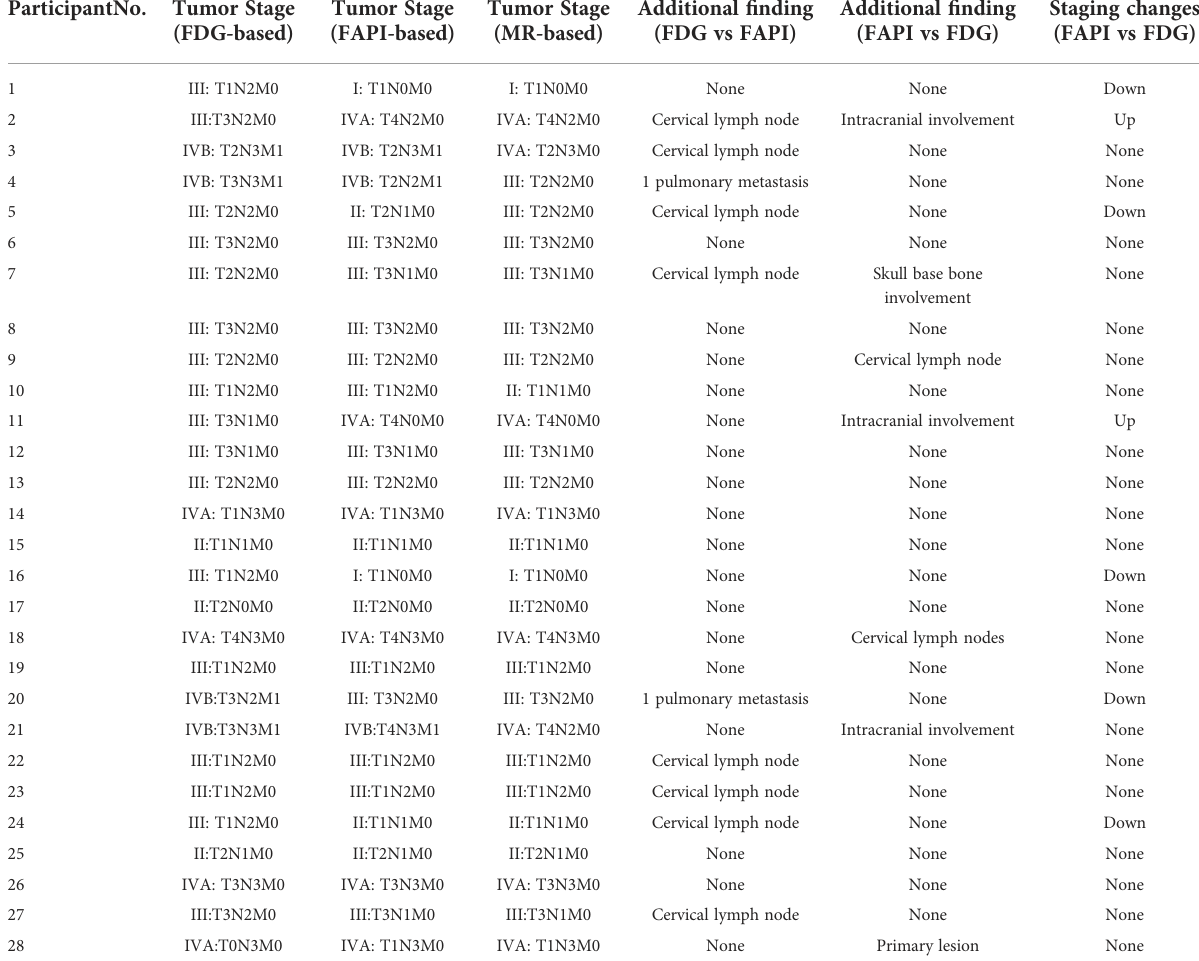
TABLE 4 Comparison of MR, 18 F-FDG, and 68 Ga-FAPI-04 PET/CT-based tumor staging (n = 28). ParticipantNo. Tumor Stage